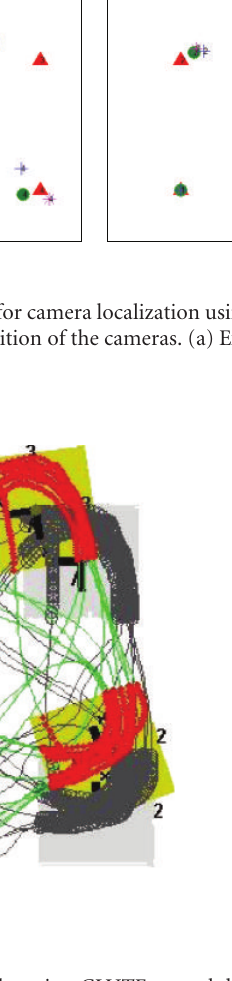
Figure 11: Network localization results using CLUTE on real data. ( black : original trajectory, green : estimated object trajectory in the unobserved areas, gray square : original camera location (field of view), and yellow square : estimated camera location (field of view).